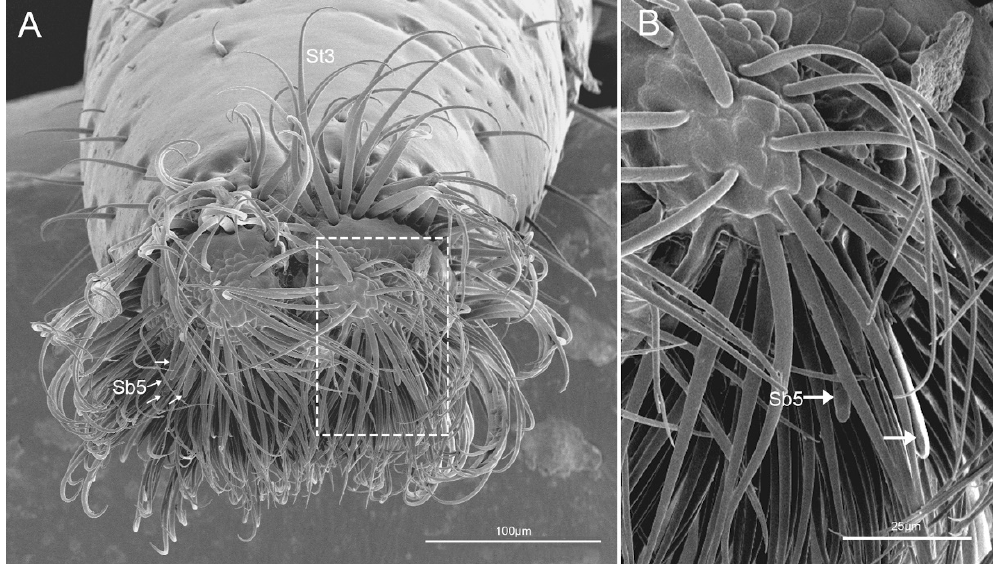
Figure 8. Tip of labium of E.fullo . ( A ) Vertical view of labial tip showing sensilla basiconica 5 (Sb5) and sensilla trichodea 3 (St3); ( B ) Enlarged view of outlined box of ( A ), showing sensilla basiconica 5 (Sb5).